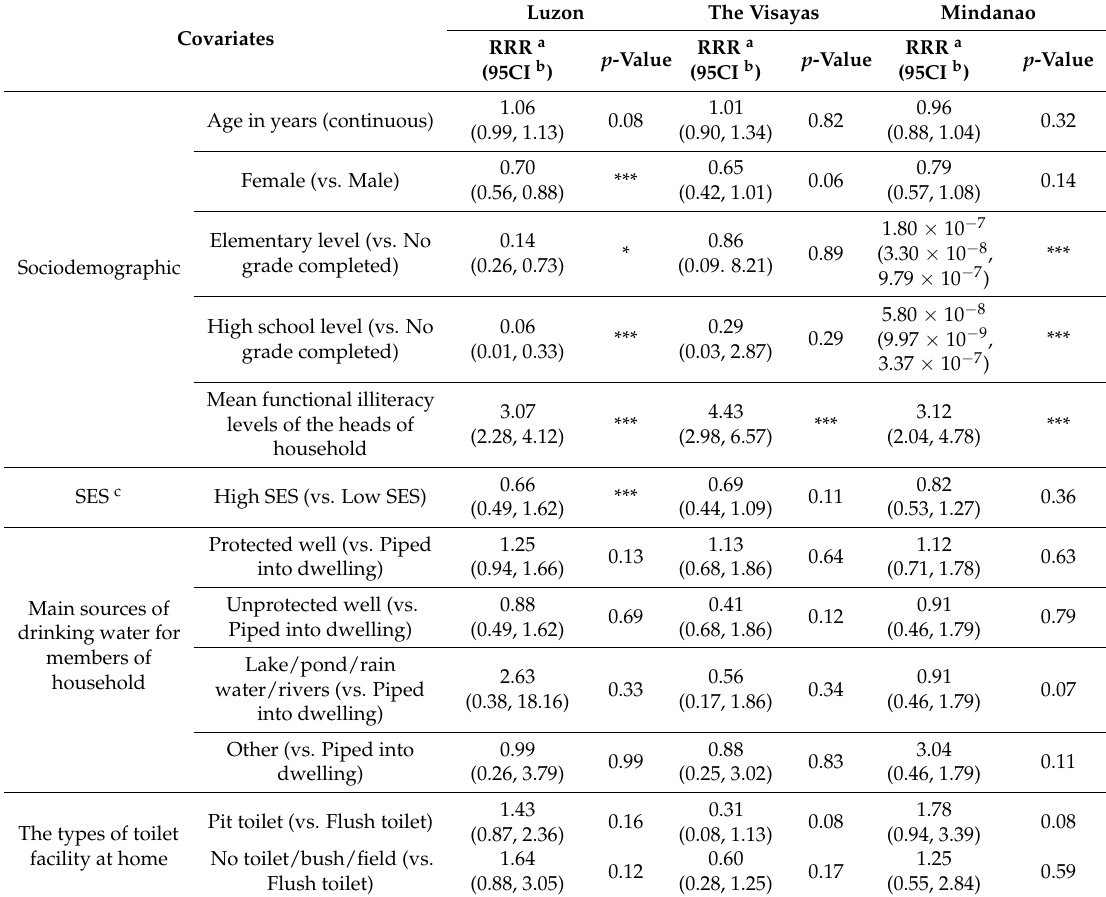
Table 5. Association of selected covariates with low functional literacy in school-aged children in the Philippines (Model